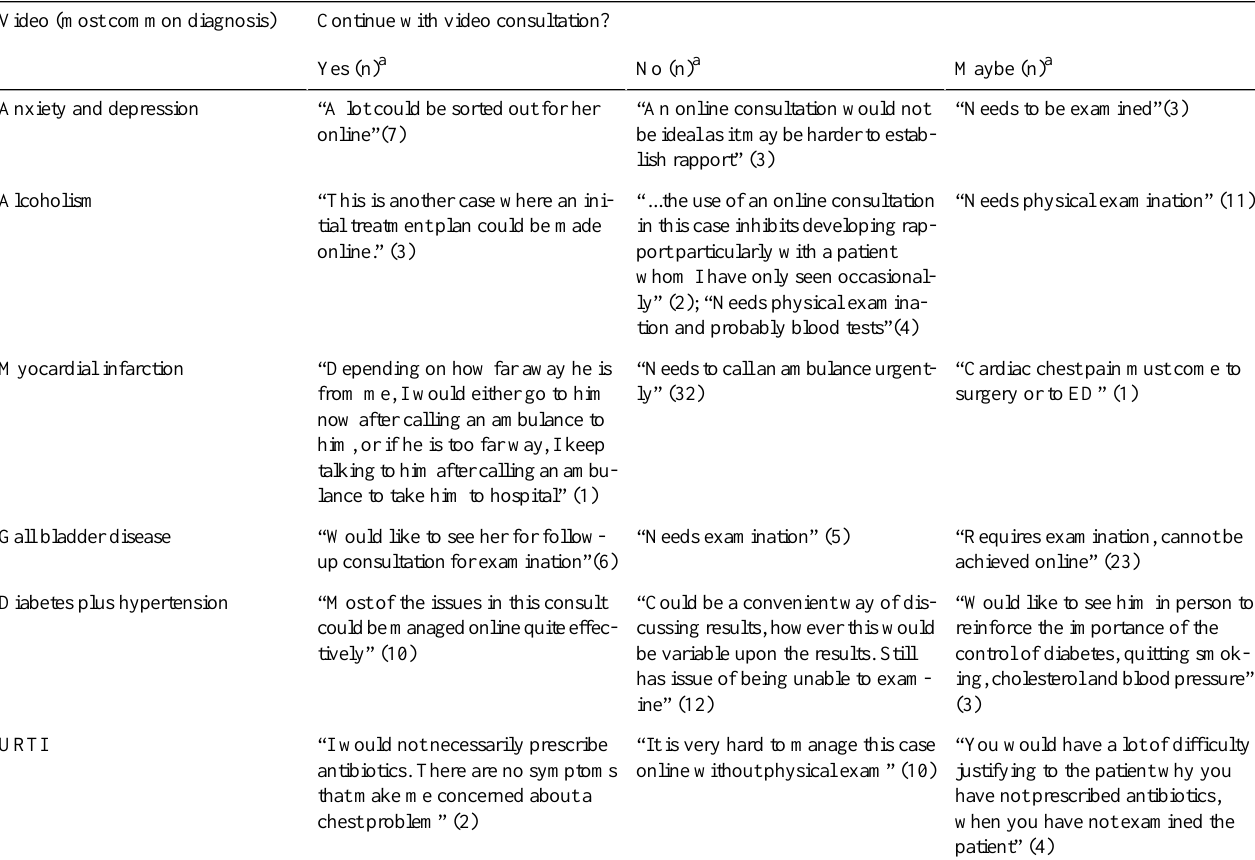
Table 9. Free-text comments per scenario.